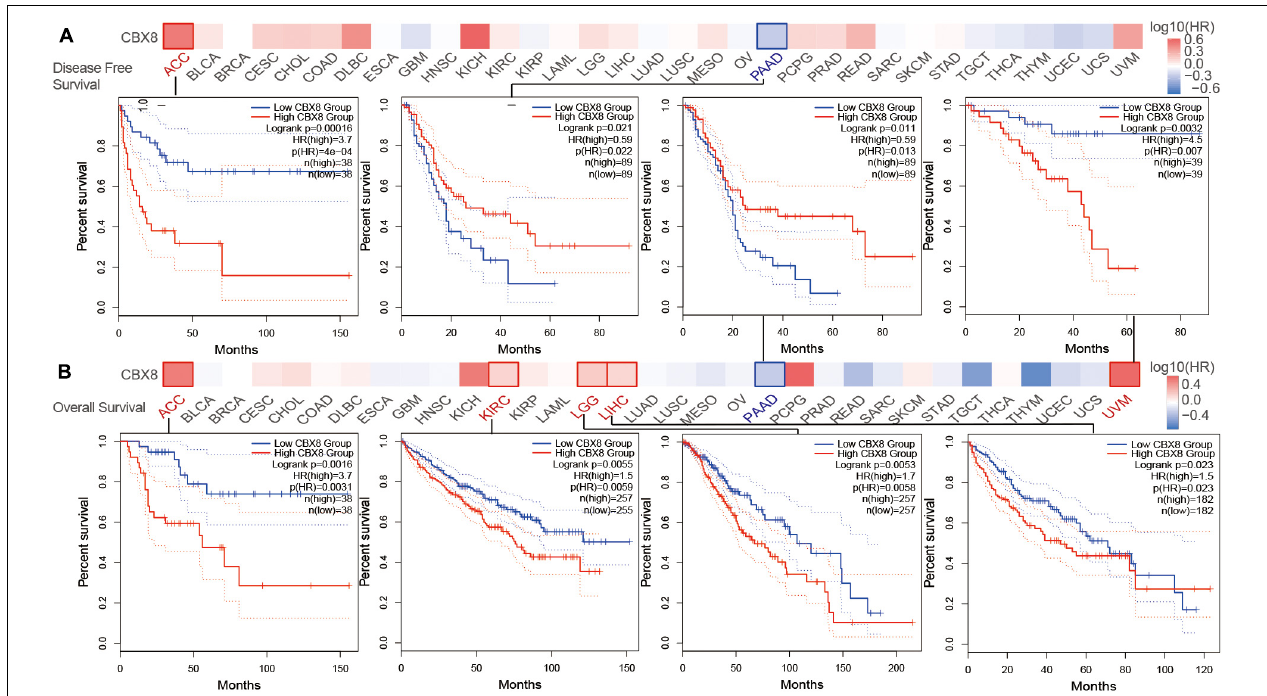
FIGURE 2 | Correlation between CBX8 gene expression and survival prognosis for tumors in TCGA analyzed with the GEPIA2 tool. (A) Disease-free survival. (B) Overall survival. The results with significant differences were visualized by a survival map and Kaplan-Meier curves.